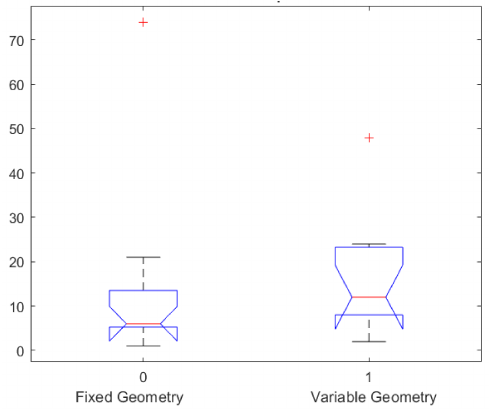
Figure 4. Boxplot of overall survival values in months in the two groups treated, respectively, with fixed and variable